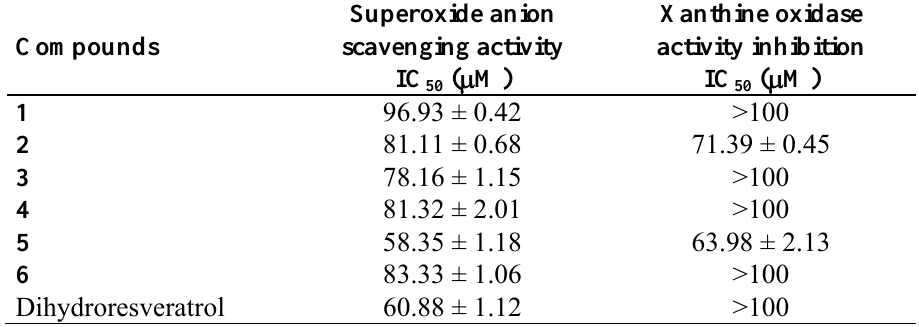
Table 5. Superoxide anion scavenging activity and xanthine oxidase activity inhibition of compounds 1 - 6 of N. nivea .